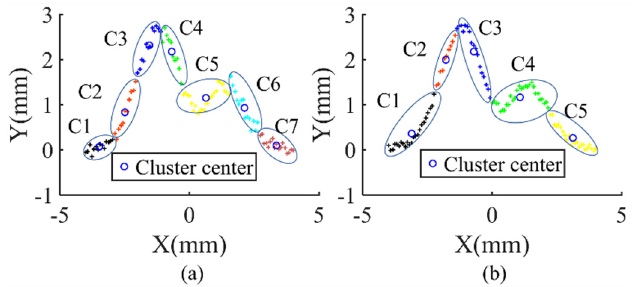
Figure 4. Clustering results: ( a ) the training samples are divided into seven clusters; ( b ) the training samples are divided into five clusters .